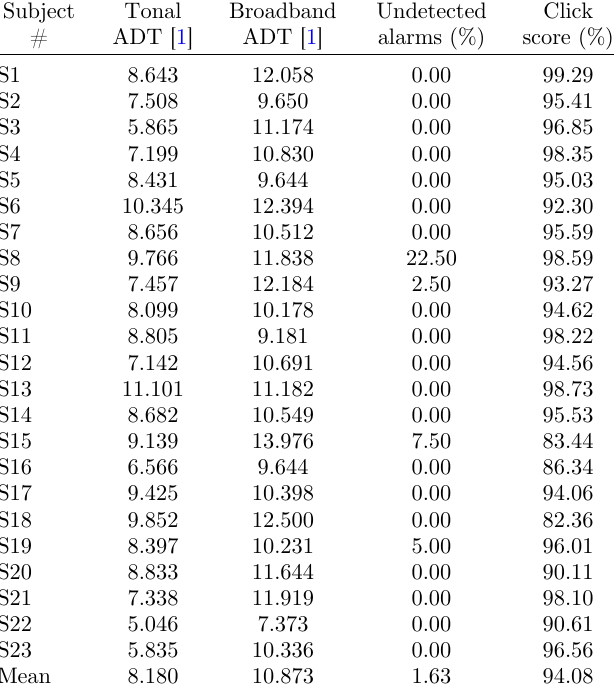
Table 2. Average detection times of reversing alarms using SFR with